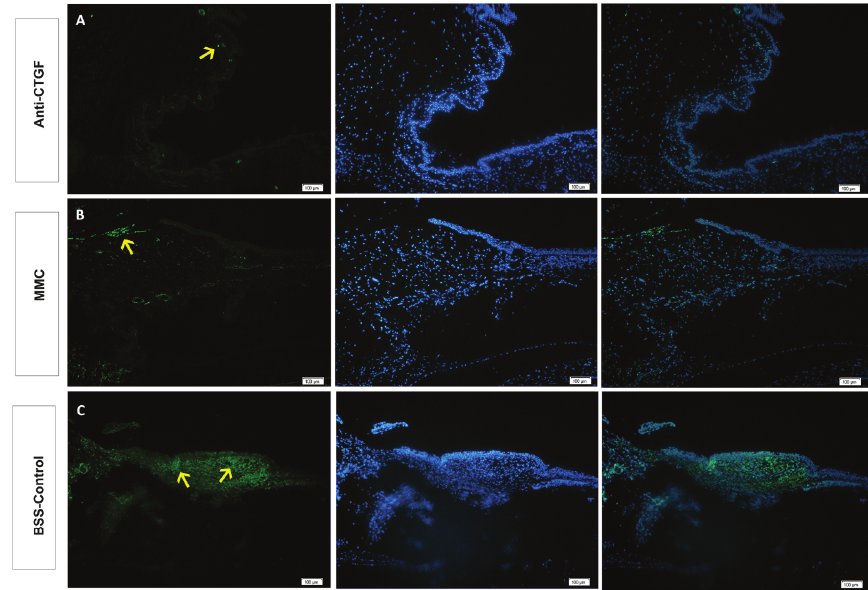
Figure 3. Representative photomicrographs of immune-stained trabeculectomy blebs for alpha-smooth muscle actin (α-SMA). Note significant immune reactivity for α-SMA in the control bleb (C) as compared to that in the anti-CTGF (A) and MMC (B) blebs. Yellow arrows indicate some concentrations of immune-stained